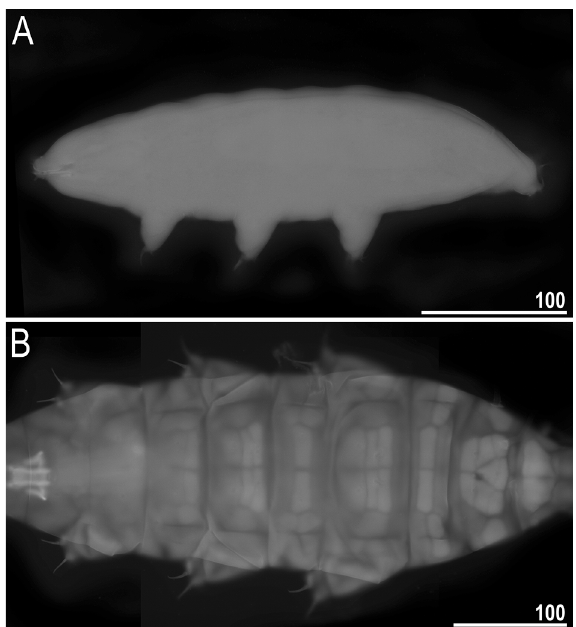
Figure 11. Evidence that not all Milnesium species exhibit pseudoplates: ( A ) M. tardigradum adult (no pseudoplates are visible); ( B ) M. variefidum adult (pseudoplates are clearly visible, especially in the caudal part of the body); both mounted in the same medium and observed under the same UVM and with the same camera. All scale bars in